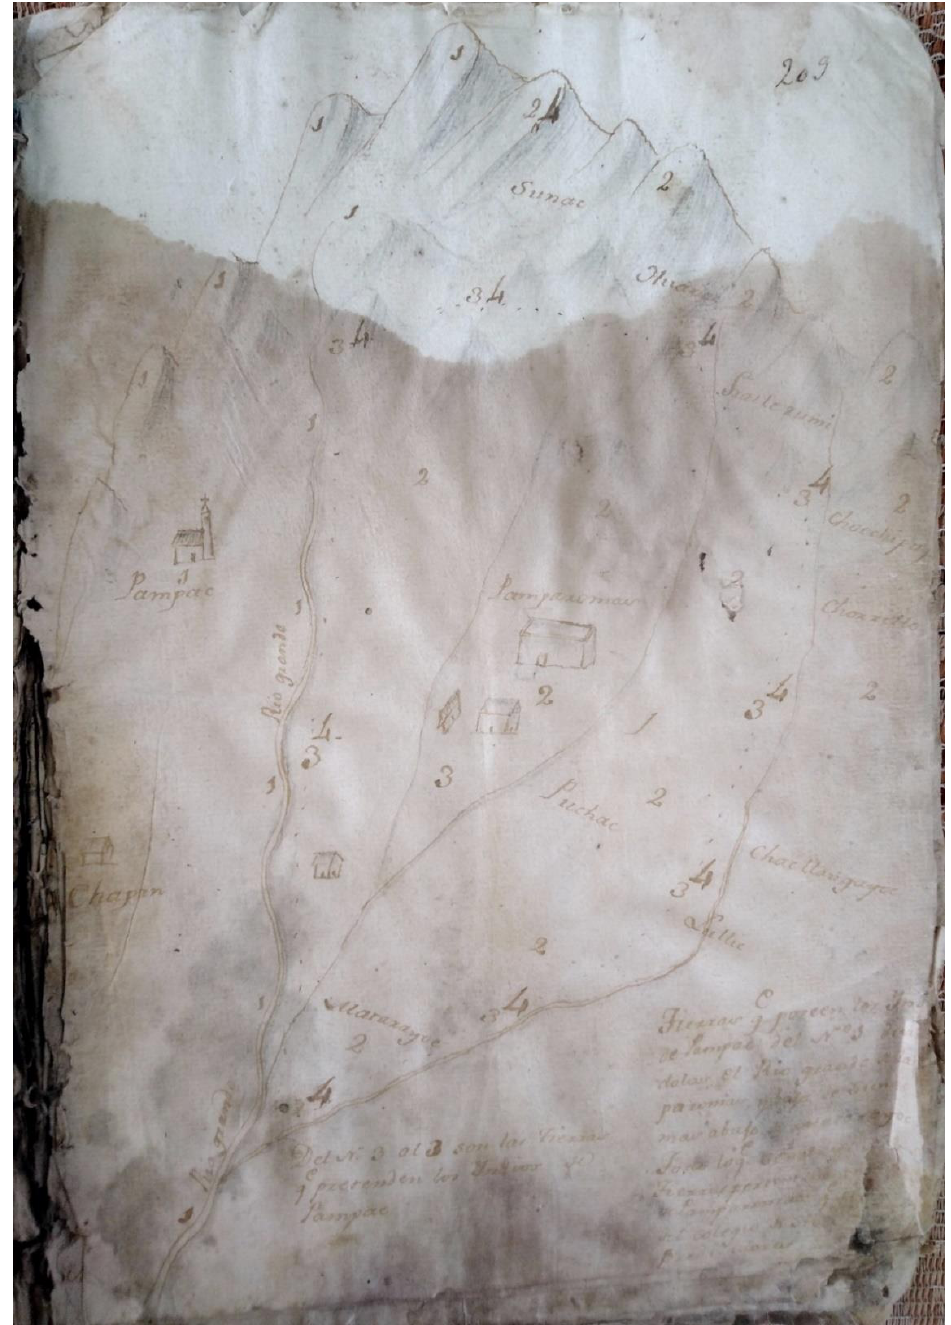
Figure 4. Map of the Pamparomás area showing the main water sources, Anexo de los Religiosos de Predicadores de Sto. Domingo con los Indios de Pamparomás (Huaráz, setiembre 1803). Extrapolating from the modern map of the area (Figure 3) I can identify the other two smaller rivers in the 1803 map as the modern Sisuran and Collapampa rivers. In toto , these four collect their waters from natural lakes or anthropogenic dams located in the high- altitude puna / páramo headwater zone directly in respect to the Uchpacancha, Sisuran, and Collapampa rivers or indirectly, as in the case of the Chanclancayo, which gathers it from three smaller tributaries — the Chorillos, Rico, and Colpa.